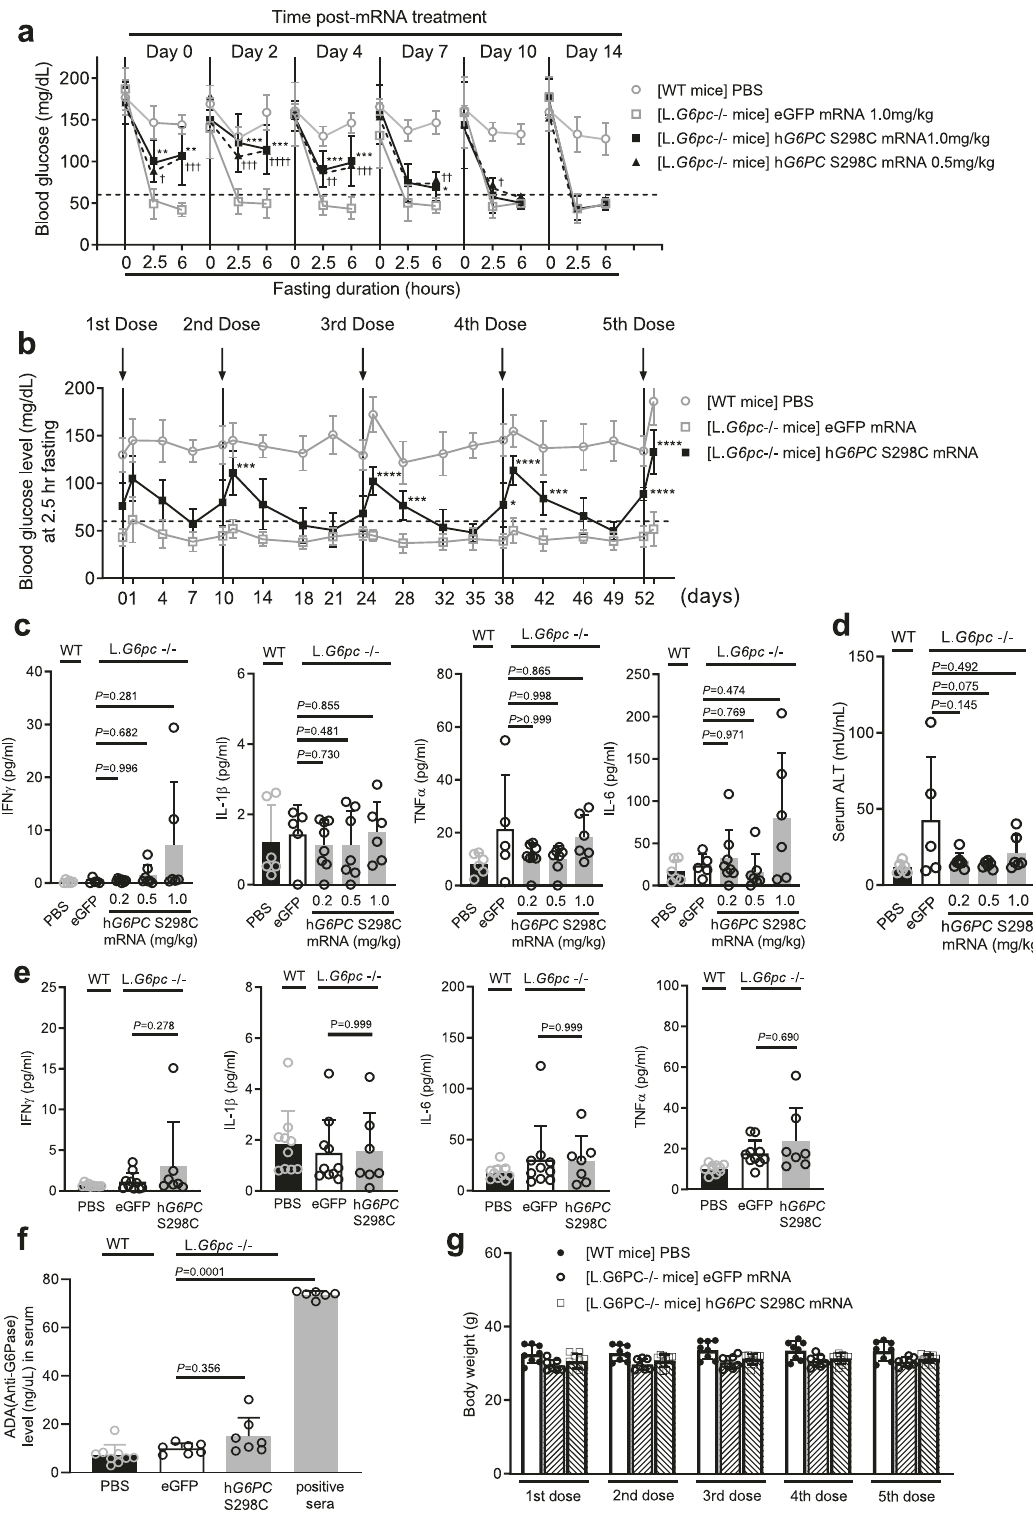
sequences (Fig. 1c). The protein translated from the engineered mRNAs was also directed to the proper subcellular compartment (endoplasmic reticulum) (Fig. 1d). When injected in a liver- speci fi c mouse model of GSD1a that recapitulates the hepatic